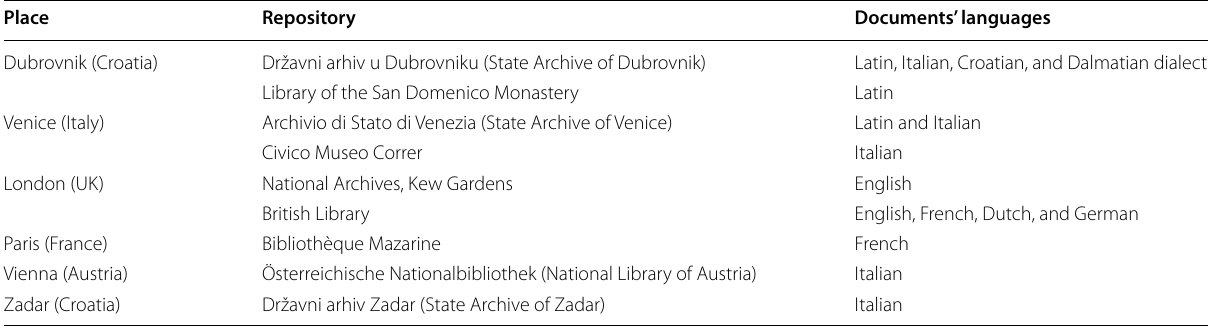
Table 1 Locations and names of visited repositories, and languages in which consulted documents were originally